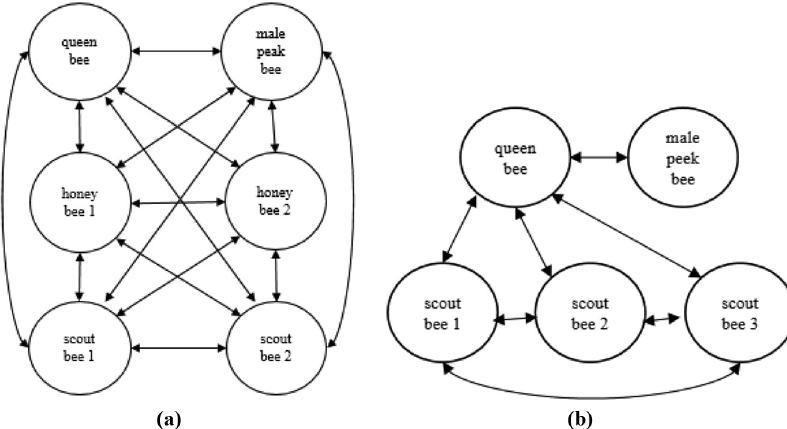
Figure 4. Two simple bee colony-sharing